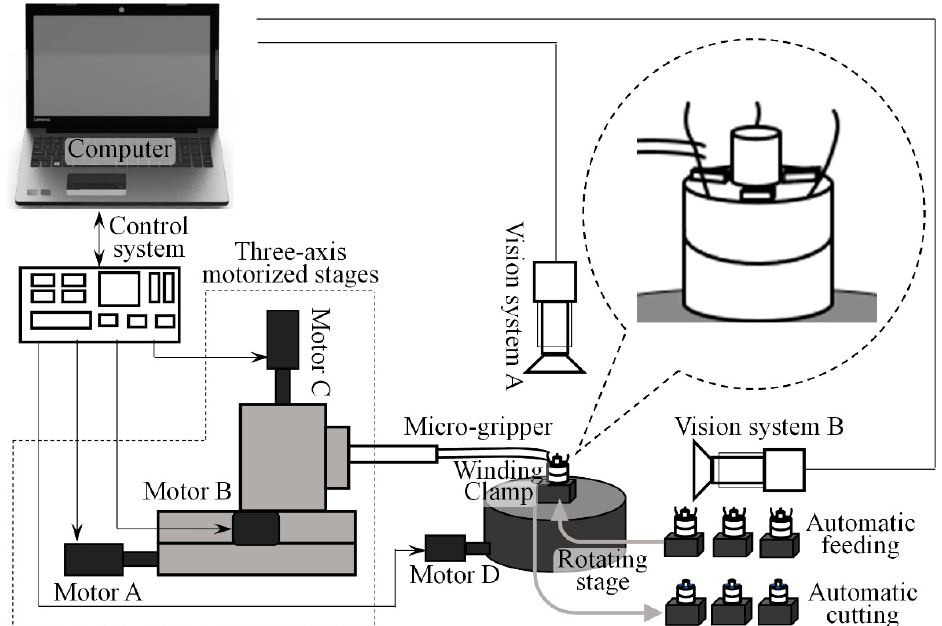
Figure 2. Setup of automated wire pulling system.